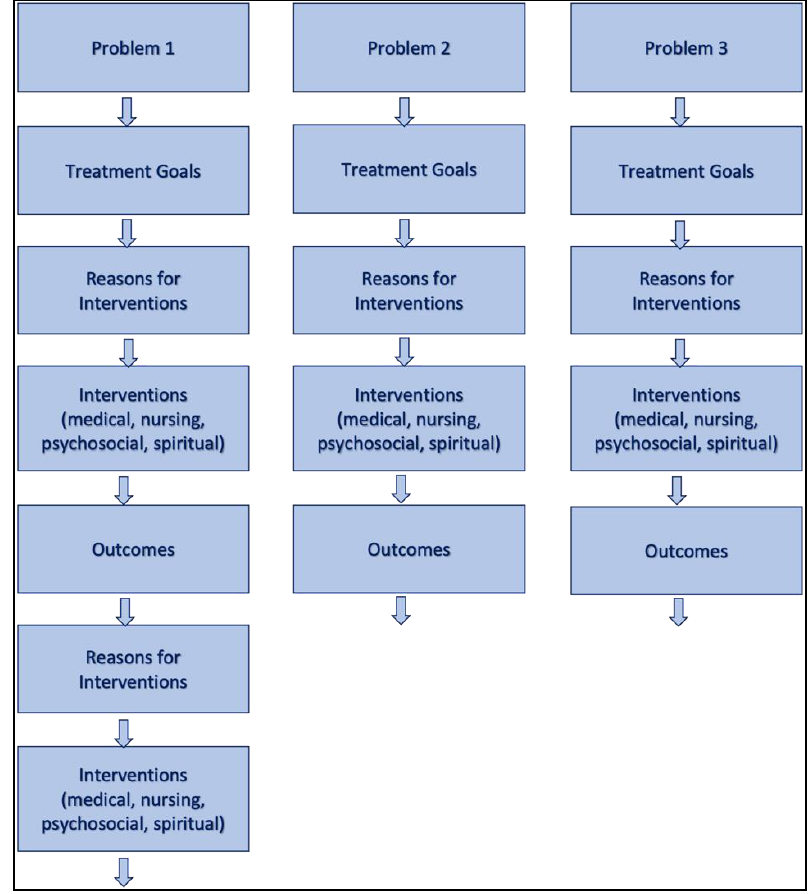
Figure 1. Exemplary scheme for the clear electronic health record (EHR) documentation of a treatment process in pediatric palliative care (PPC).